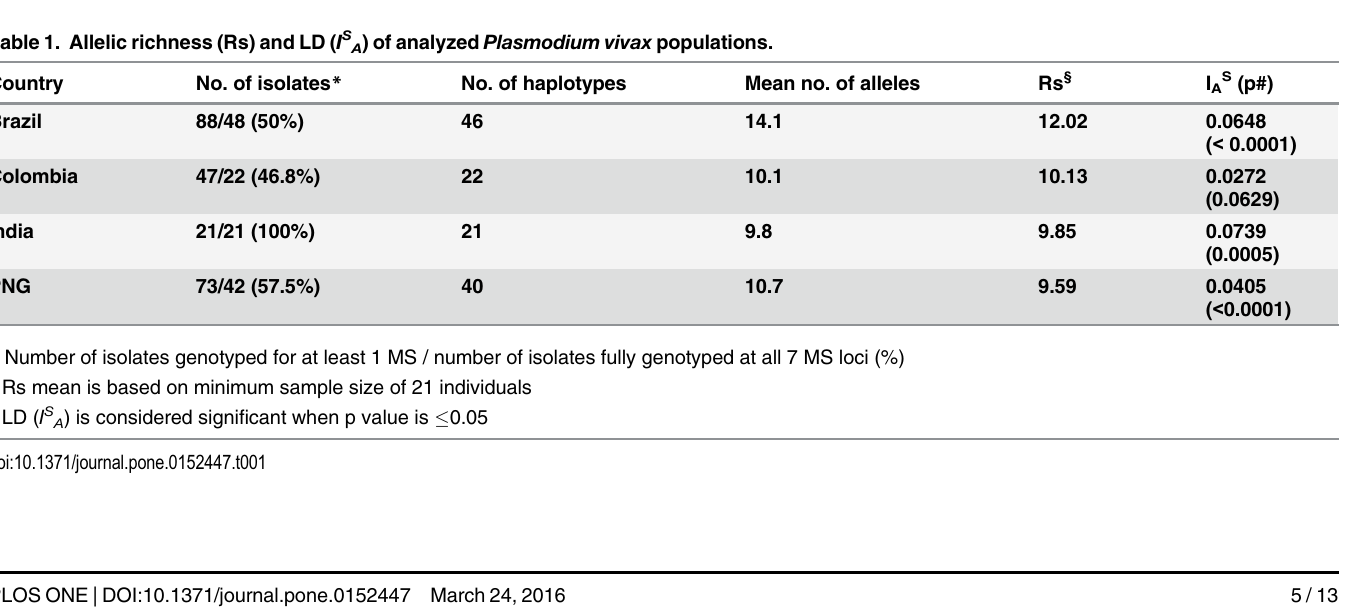
Table 1. Allelic richness (Rs) and LD ( I S A ) of analyzed Plasmodium vivax populations. Country